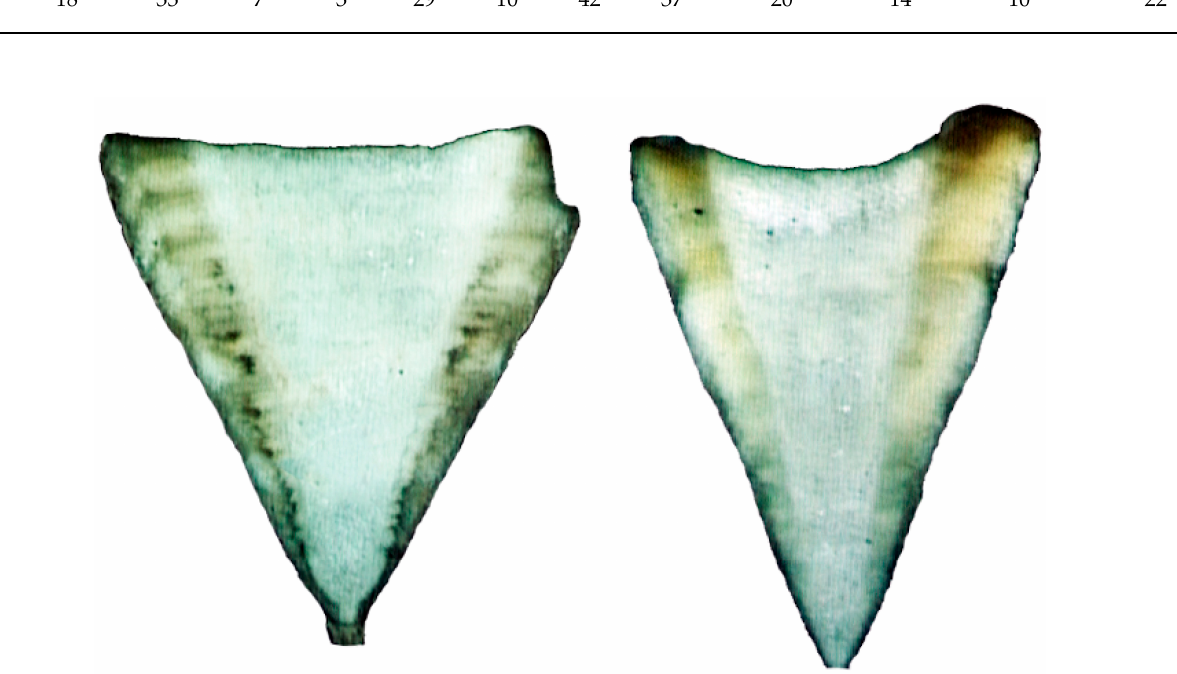
Figure 2. Sagittal sections of centra where growth bands were not evident and could not be read. Table 1. Monthly sample size of Narcine entemedor specimens analyzed in the present study.